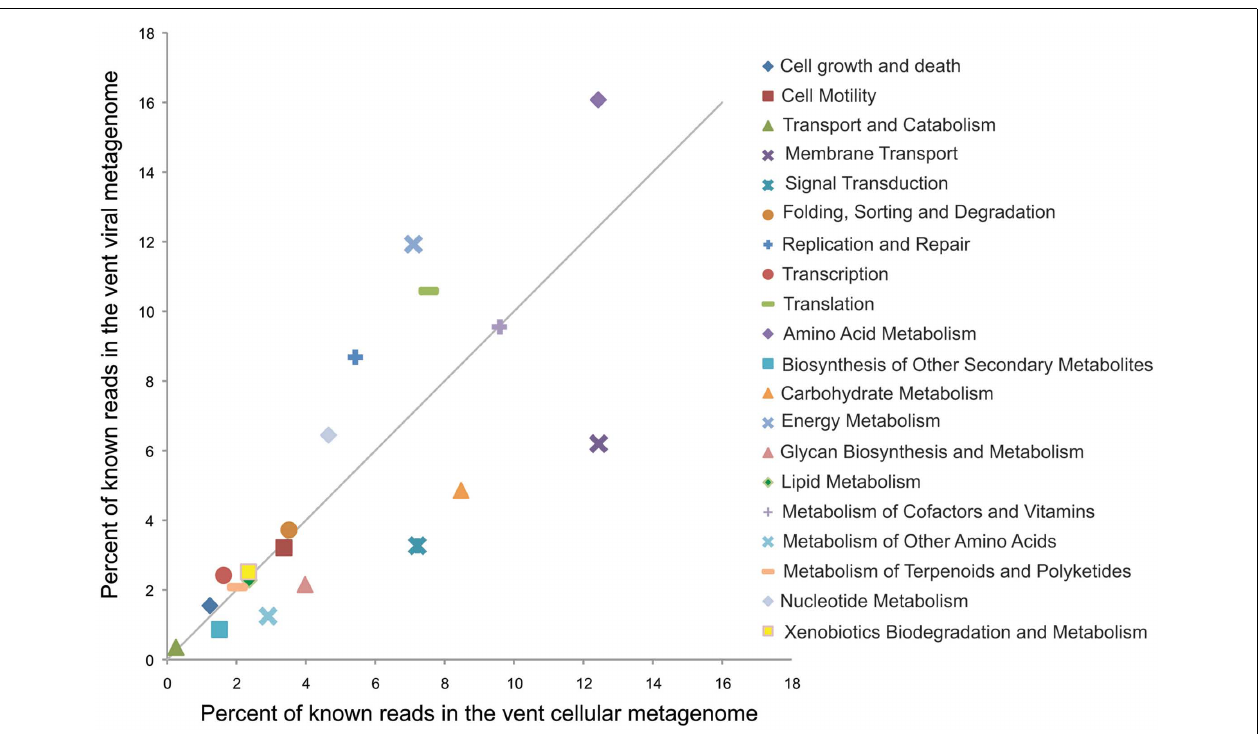
ratio between the viral and cellular metagenomes. Metagenomes were analyzed with MG-RAST (Meyer et al., 2008), and reads were annotated with the KEGG Orthology database, release